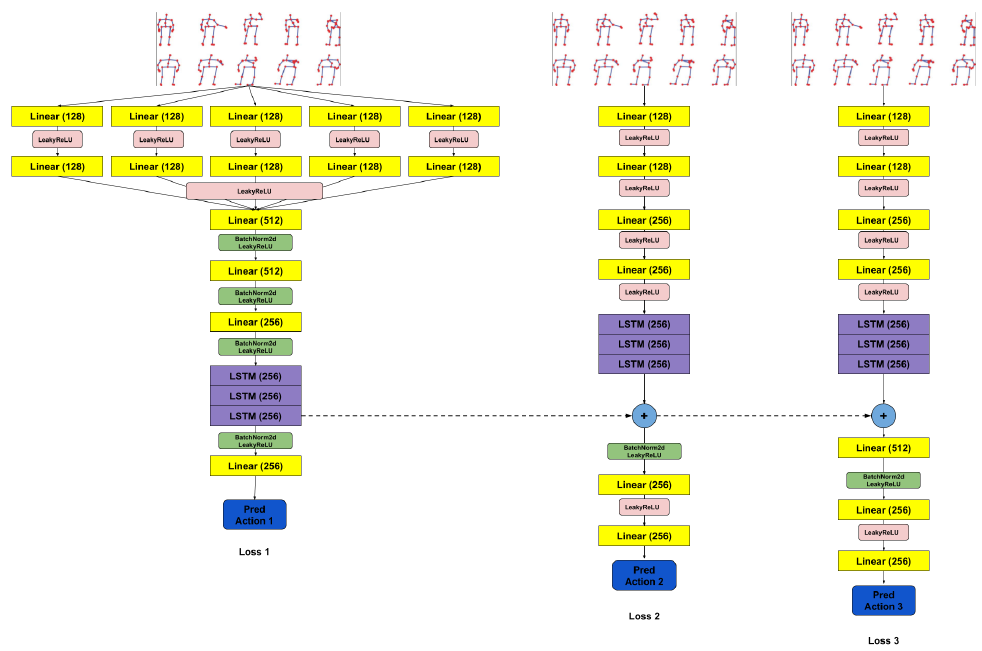
Figure 6. The architecture of the neural network used to recognize human